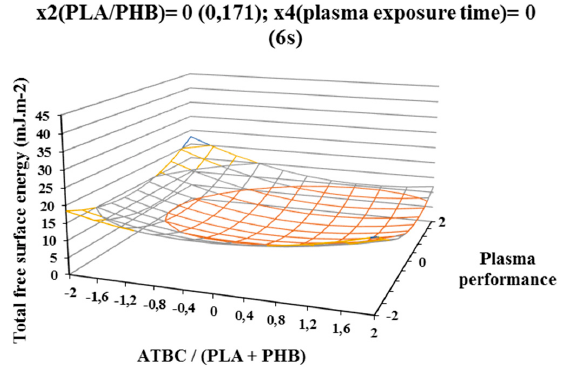
Figure 8. Response surface of total free surface energy difference measured 5 h after plasma surface treatment, depending on factors x1 (ATBC/(PLA + PHB)) and x3 (plasma power) at a constant factor x2 (PHB/PLA) = − 2 and x4 (exposure time) plasma) = − 2.